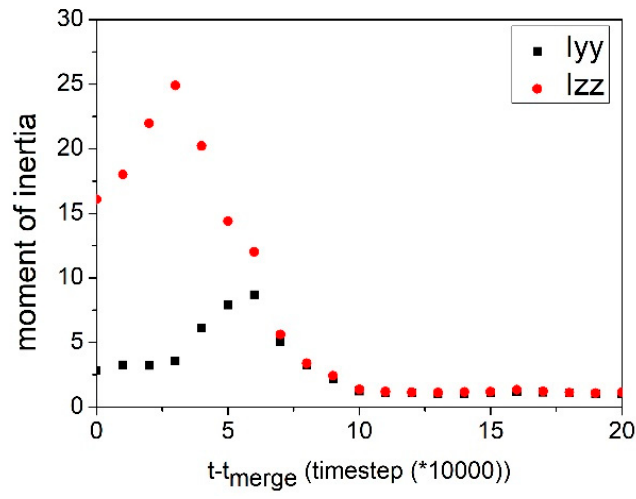
Figure 8. Shape characterization by moment of inertia after merging. I xx , I yy , and I zz are the principal moments of inertia of the aggregate.